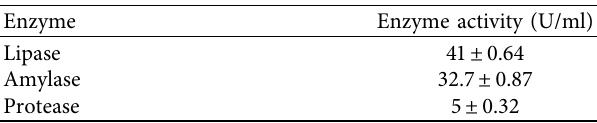
Table 1: Extracellular enzymes secreted by K . flava Y4 and their activities. Enzyme Enzyme activity (U/ml) Lipase 41 ± 0.64 Amylase 32.7 ± 0.87 Protease 5 ±